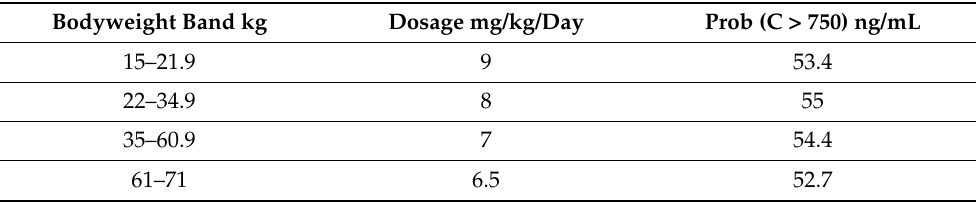
Table 3. Hydroxychloroquine dosage recommendation in mg/kg/day to achieve blood